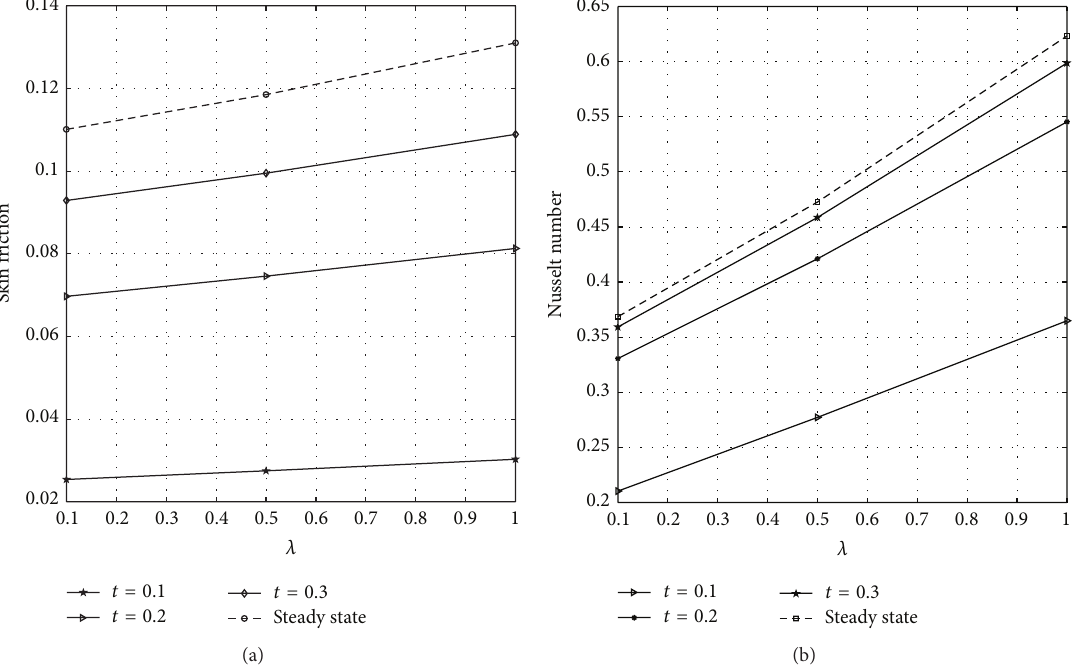
Figure 10: Variation of skin friction and Nusselt number with 𝜆 and time ( 𝑡 ) at 𝑦 = 1